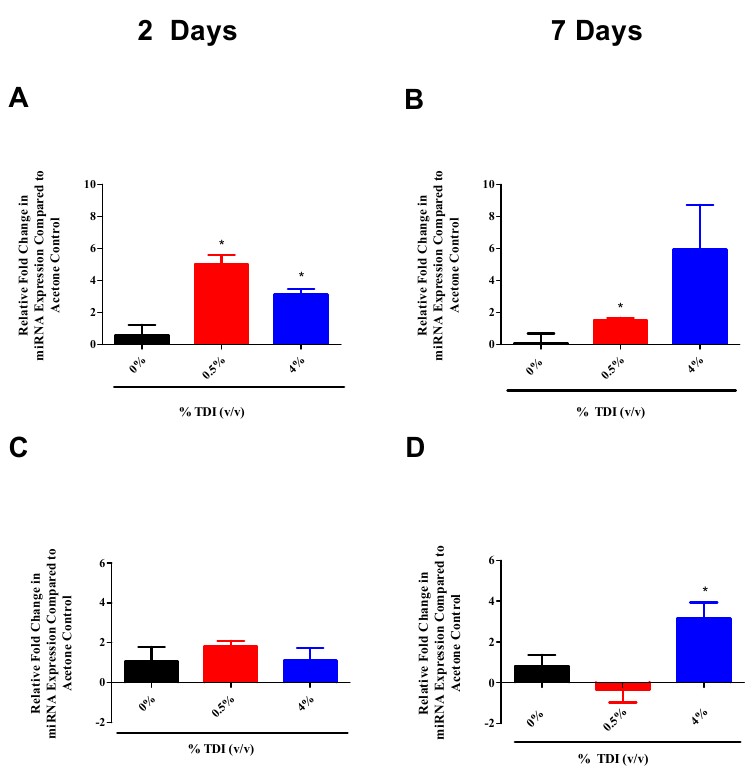
Figure 7. Mature miR ‐ 31 and ‐ 155 expression increases in T regs during TDI sensitization. RT ‐ PCR analysis of miR ‐ 31 ( A , B ) and ‐ 155 ( C , D ) expression in the dLN T reg subset at two and seven days post TDI exposure. T regs were isolated as CD4 + CD25 + cells and cellular purity was assessed via flow cytometric staining for CD3 + CD4 + Foxp3 + events (2 days: % T regs of all CD4 + events, mean, n = 4–5 per group: Acetone: 83.8% ± 1.6%, 0.5% TDI: 67.1% ± 4.2%, and 4% TDI: 72.3% ± 1.9%; 7 days: % T regs of all CD4 + events, Acetone: 91%, 0.5% TDI: 88.4%, and 4% TDI: 86.7%). Bars represent mean relative fold change (± SE) of 4–5 mice per group. Statistical significance is represented by * ( p < 0.05).